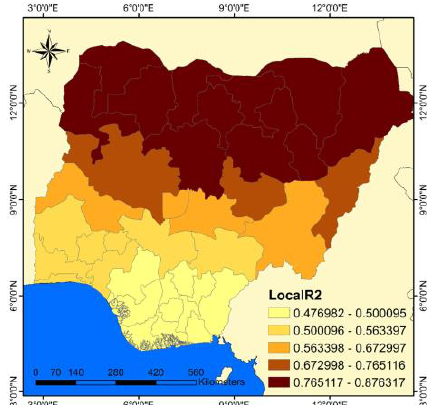
Figure 3. Local R2 smoothing for GWR showing model‟s fitness spatial